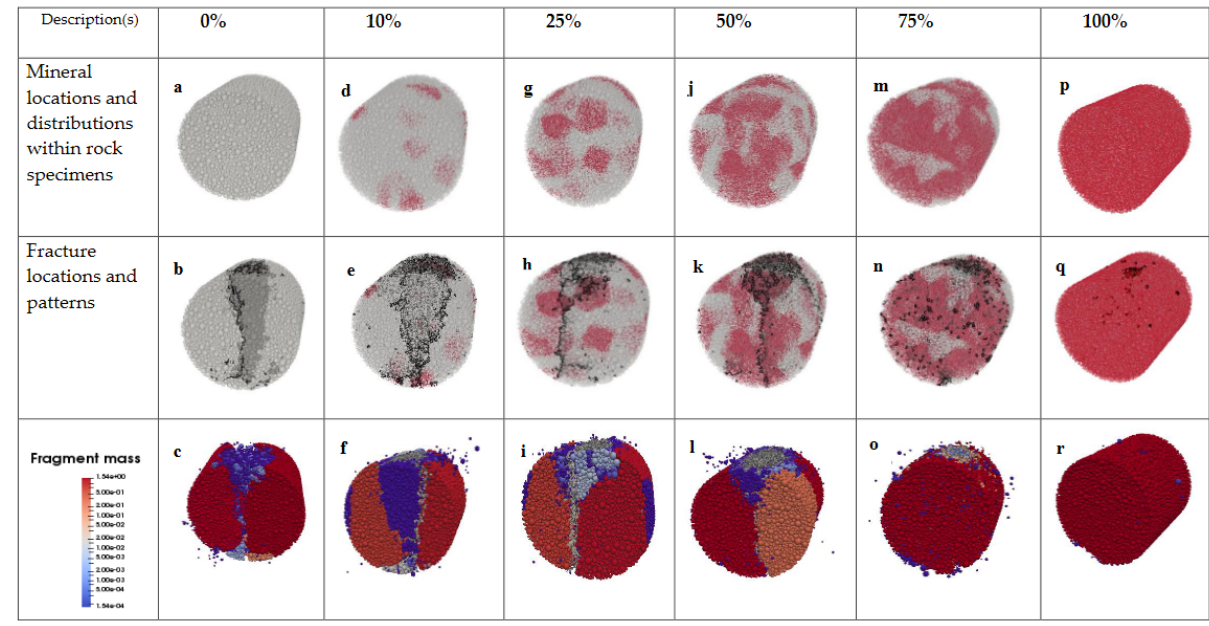
Figure 18. Locations and distributions of valuables within rock specimens, fracture locations and paths within rock specimens, fragmentation of specimens. ( a ) rock specimen with 0% mineral grade, ( b ) Fracture locations and patterns at 0% mineral grade, ( c ) Fragment mass at 0% mineral grade, ( d ) rock specimen with 10% mineral grade, ( e ) Fracture locations and patterns at 10% mineral grade, ( f ) Fragment mass at 10% mineral grade, ( g ) rock specimen with 25% mineral grade, ( h ) Fracture locations and patterns at 25% mineral grade, ( i ) Fragment mass at 25% mineral grade, ( j ) rock specimen with 50% mineral grade, ( k ) Fracture locations and patterns at 50% mineral grade, ( l ) Fragment mass at 50% mineral grade, ( m ) rock specimen with 75% mineral grade, ( n ) Fracture locations and patterns at 75% mineral grade, ( o ) Fragment mass at 75% mineral grade, ( p ) rock specimen with 100% mineral grade, ( q ) Fracture locations and patterns at 100% mineral grade and ( r ) Fragment mass at 100% mineral grade